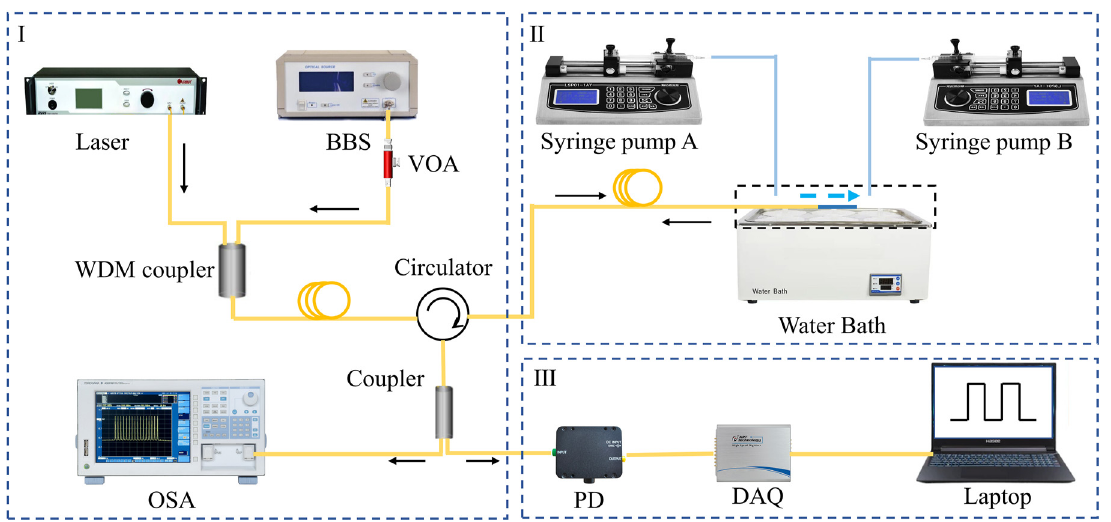
Figure 6: Schematic of the fluidics flow rate measuring system. BBS, broadband light source; VOA, variable optical attenuator; WDM, wavelength division multiplexer; PD, photoelectric detector; DAQ, high-speed data acquisition card.